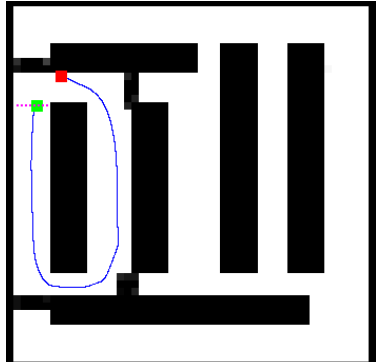
Figure 8. This is a successful sample of one robot with learned obstacle-avoiding policy completing the test. The red square is the start position, and the pink dotted line is the finish line. The green square is the position that the robot arrived at the finish line.